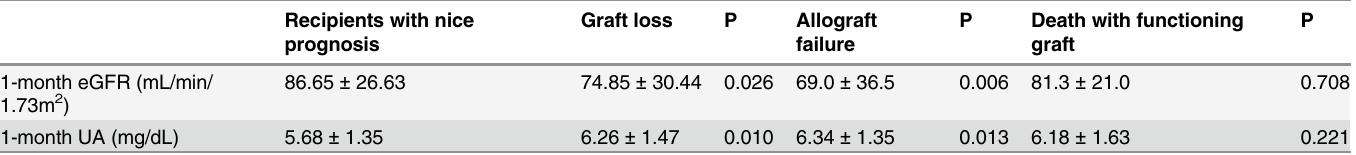
Table 6. 1-month post-transplant eGFRs and UAs for patients of different outcomes. All P values are the results compared with recipients with nice prognosis group.